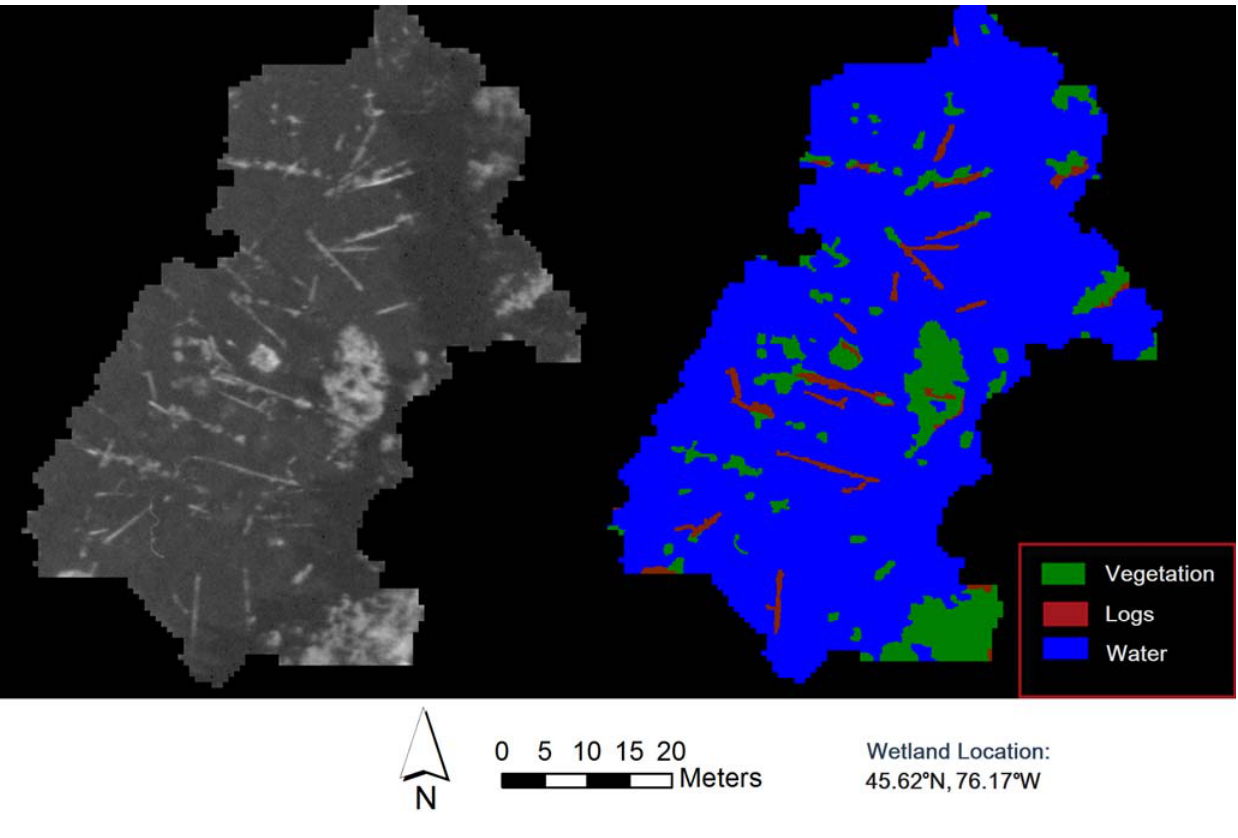
Figure 8. Orthophoto of a wetland (from the wetland mask) and the resulting classification of three Blanding’s turtle habitat attributes: water, wetland vegetation, and logs [66].